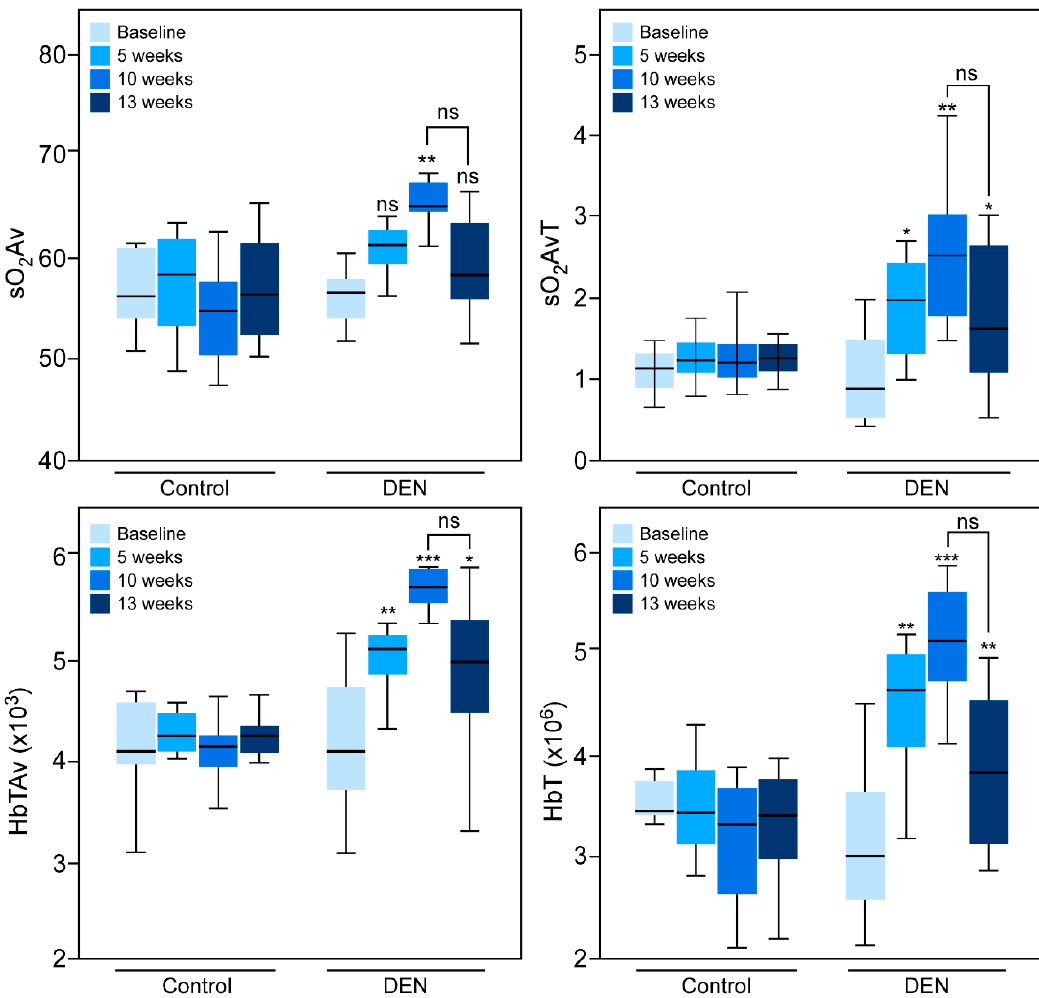
Figure 2. Quantitative analyses of hepatic PA signals. Values of oxygen saturation (average = sO 2 Av and average total = sO 2 AvT) and hemoglobin concentration (average = HbTAv and average total = HbT) were obtained for 12 rats, prior to the start of DEN consumption (baseline) and 5, 10, and 13 weeks after DEN administration, and then averaged. The mean values (± SEM) were plotted. Note that as the hepatic fibrosis developed there were statistically significant increases in each parameter at the 10 ‐ week time point. The ANOVA p ‐ values between baseline and 10 weeks for sO 2 Av, sO 2 AvT, HbTAv, and HbT were 0.01, 0.02, 0.0003, and 0.0001, respectively. Control rats showed no increase in these parameters over time. Statistical significance was assigned as * for p ≤ 0.05, ** for p ≤ 0.01, and *** for p ≤ 0.001, and ns for non ‐ significant.